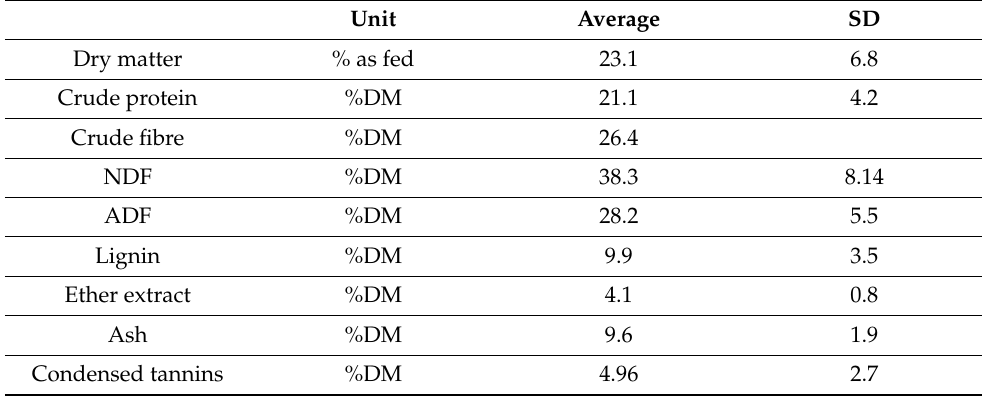
Table 8. Nutritional value of Lotus corniculatus L.